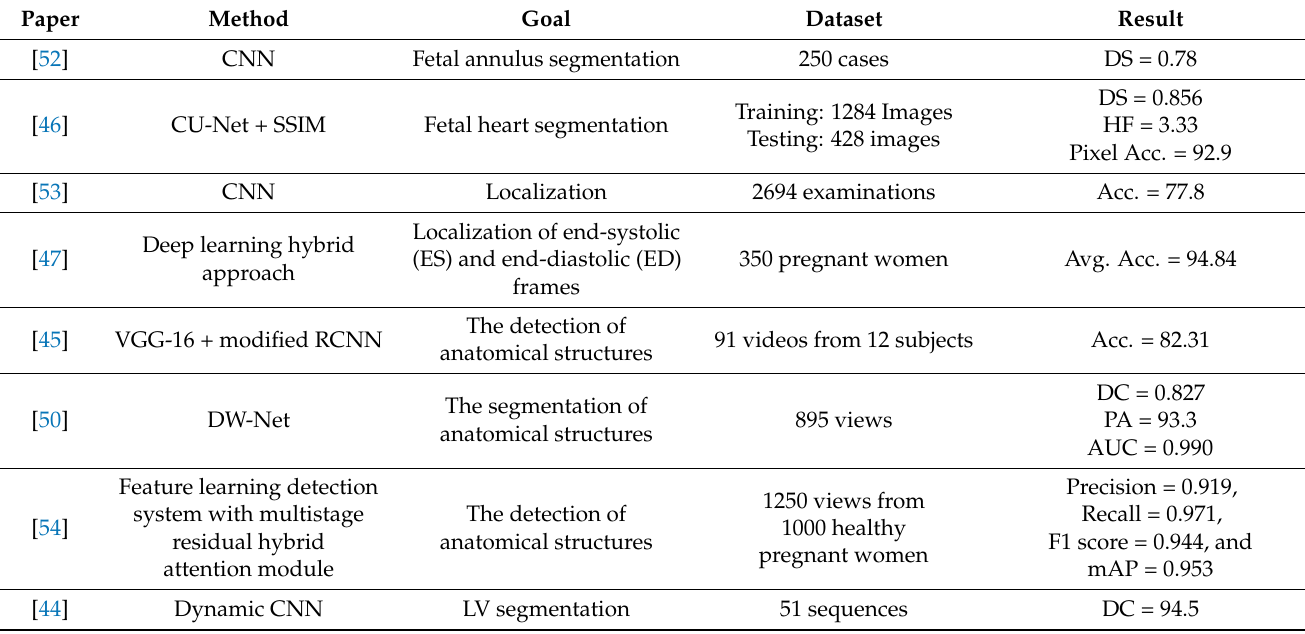
Table 2. Deep learning segmentation techniques for fetal heart ultrasound images and